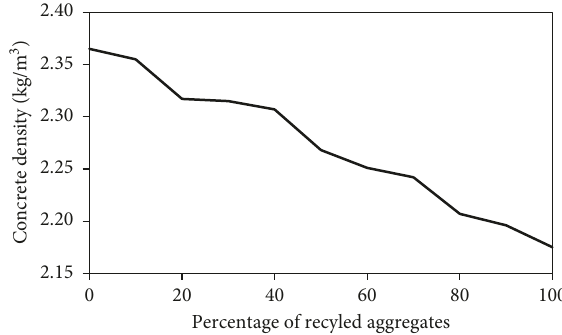
Figure 6: Unit weights of different